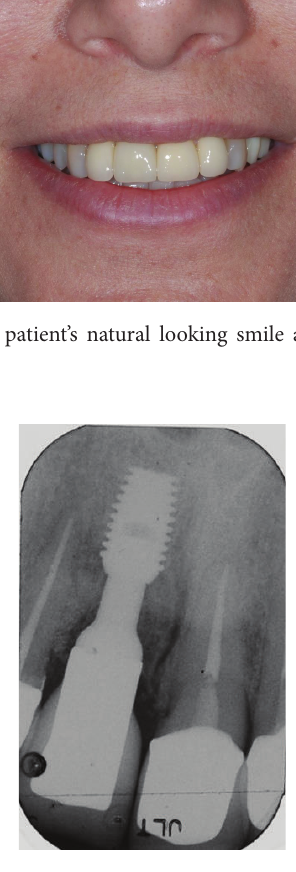
Figure 28: Control X-ray at the end of therapy.